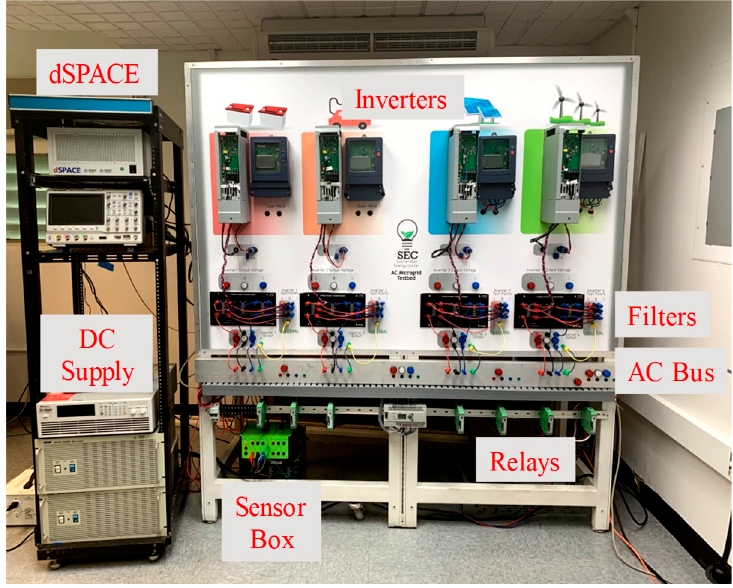
Figure 4. Photo of the experimental setup.